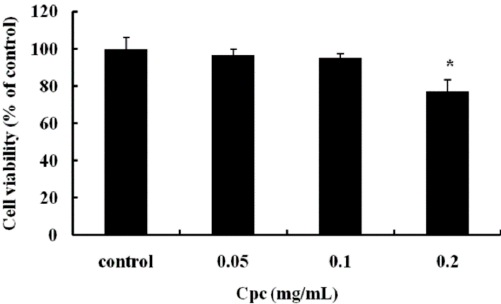
Figure 5. Effect of C-phycocyanin (Cpc) on B16F10 murine melanoma cell viability. The asterisk (*) indicates a significant difference from control group (*, p < 0.05). Published by Ref. [35].